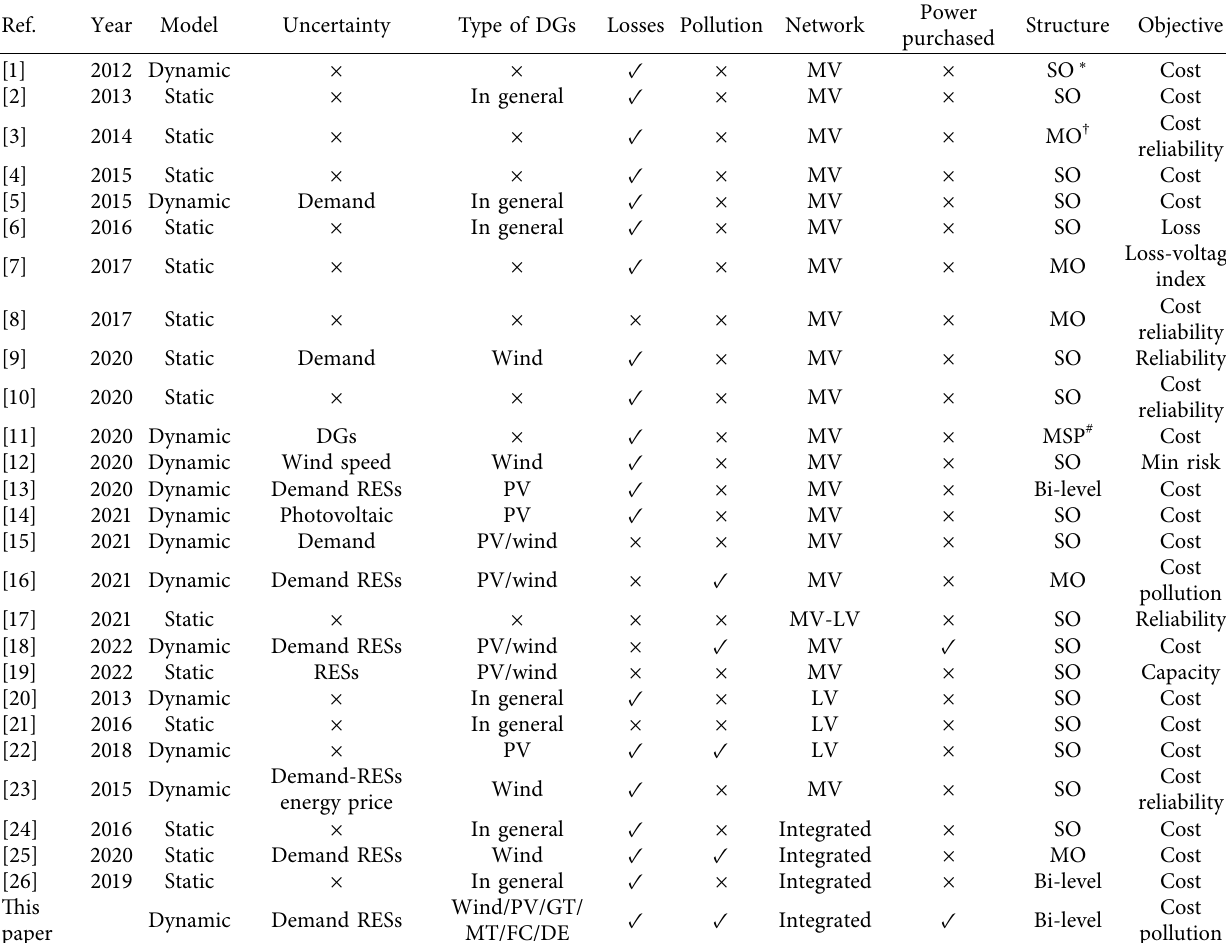
Table 1: Relevant features of studies reported in the literature and the model of this paper.